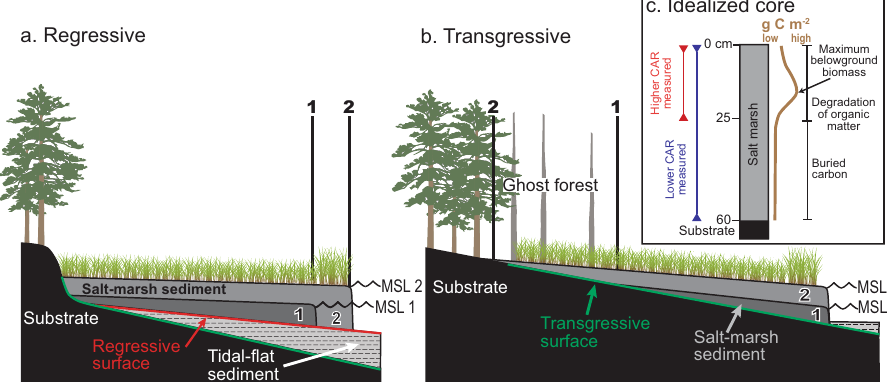
Fig. 1 Conceptual models illustrating fringing salt marsh ontogeny and carbon burial with sea-level rise. The shoreline of a regressive salt marsh moves into the estuary (basinward; a ) and the landward edge of a transgressive salt marsh moves into the upland (landward; b ) with sea-level rise from time 1 – 2. These models represent the types of salt marshes examined in this study; however, other salt marshes are accreting at rates <sea-level rise, have eroding shorelines, or are expanding in both landward and basinward directions. A typical down-core pro fi le of carbon storage in a salt marsh ( c ) illustrating the higher and lower carbon accumulation rates that result from integrating over short (0 – 25 cm) and long (0 – 60 cm) intervals and associated time scales, respectively. Depths shown are hypothetical and vary among and within salt